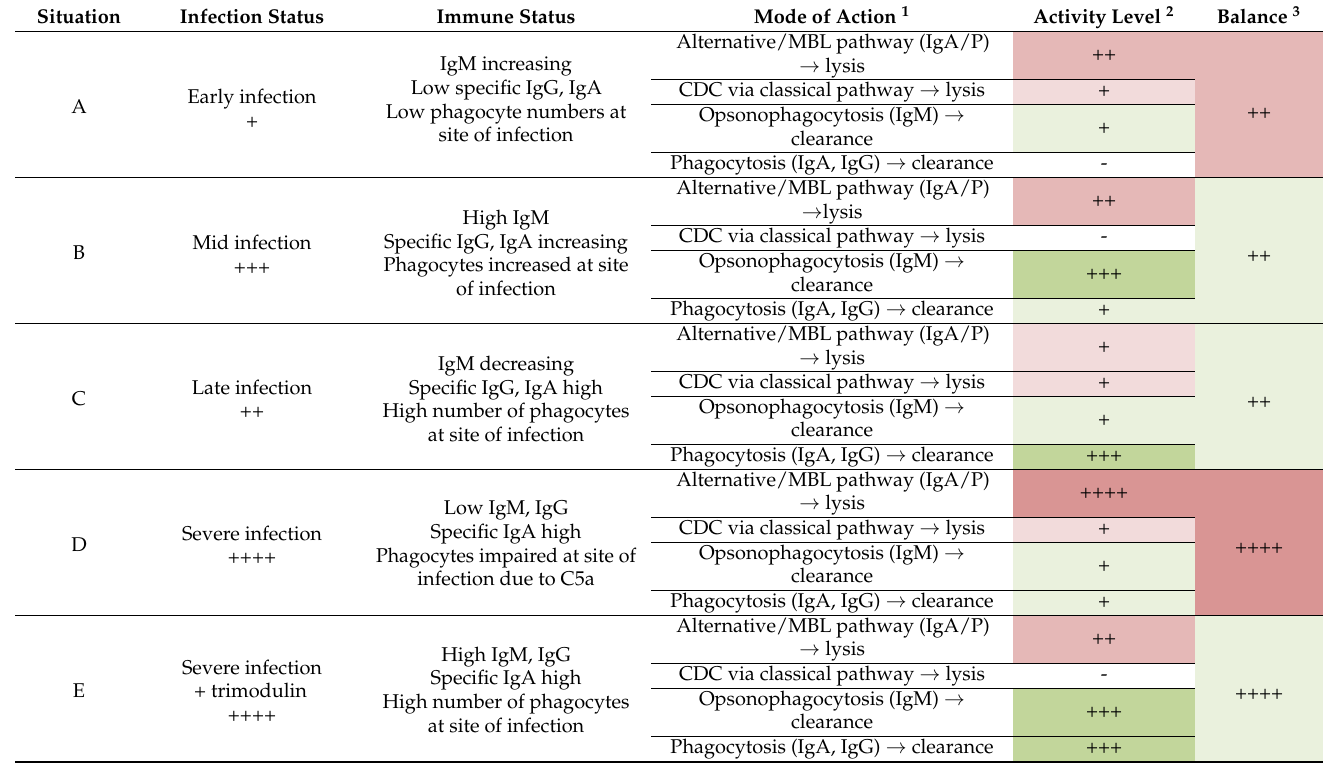
Table 2. Overview of the influence of IgM, IgA, and IgG on the modes of action of the complement system during the different infection